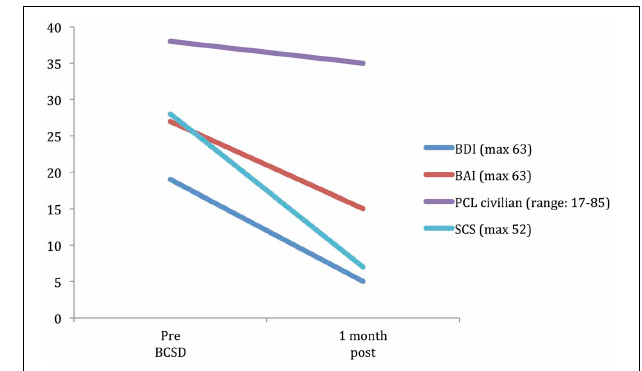
FIGURE 4 | Time Course of Psychiatric symptom ratings for Case 2 during 1 month follow